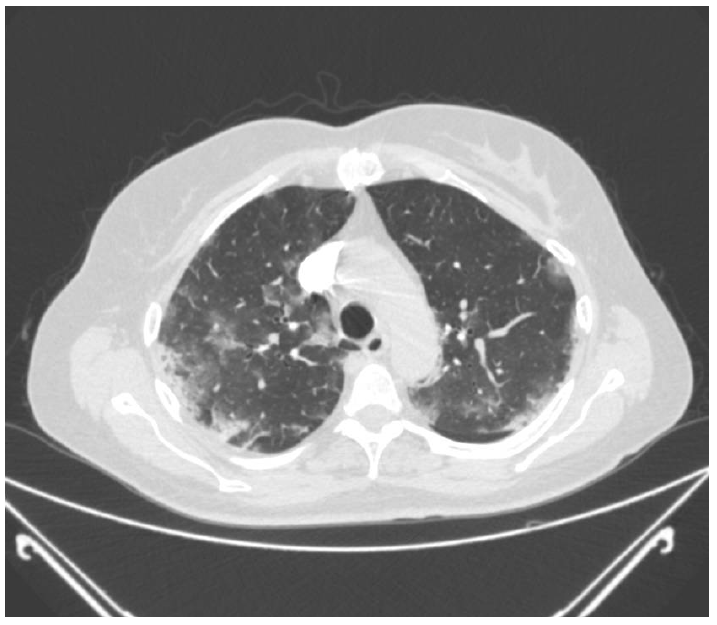
Figure 1. Ground-glass opacities on chest CT in a patient with COVID-19-related